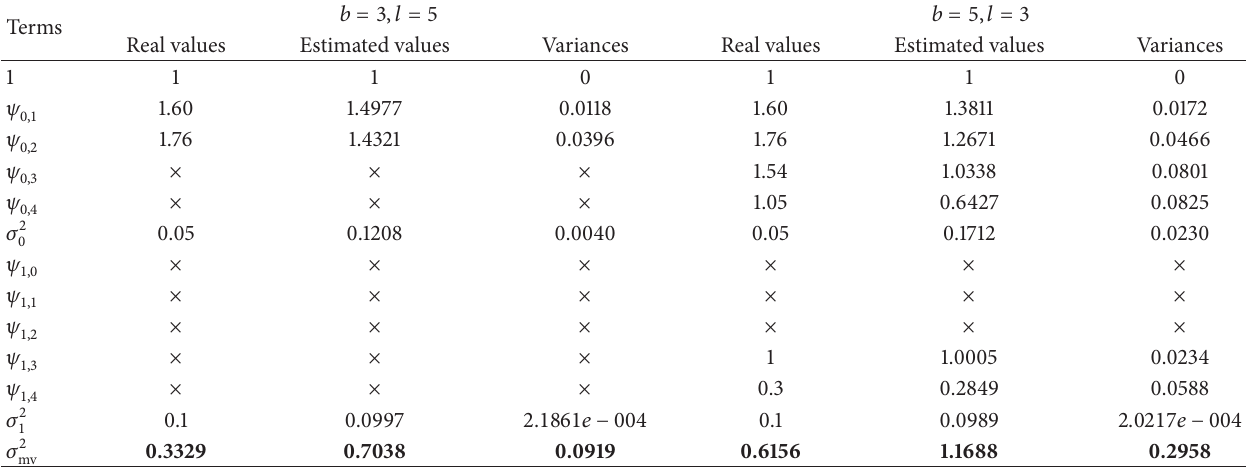
Table 1: The obtained model coefficients and minimum variance by linear estimation